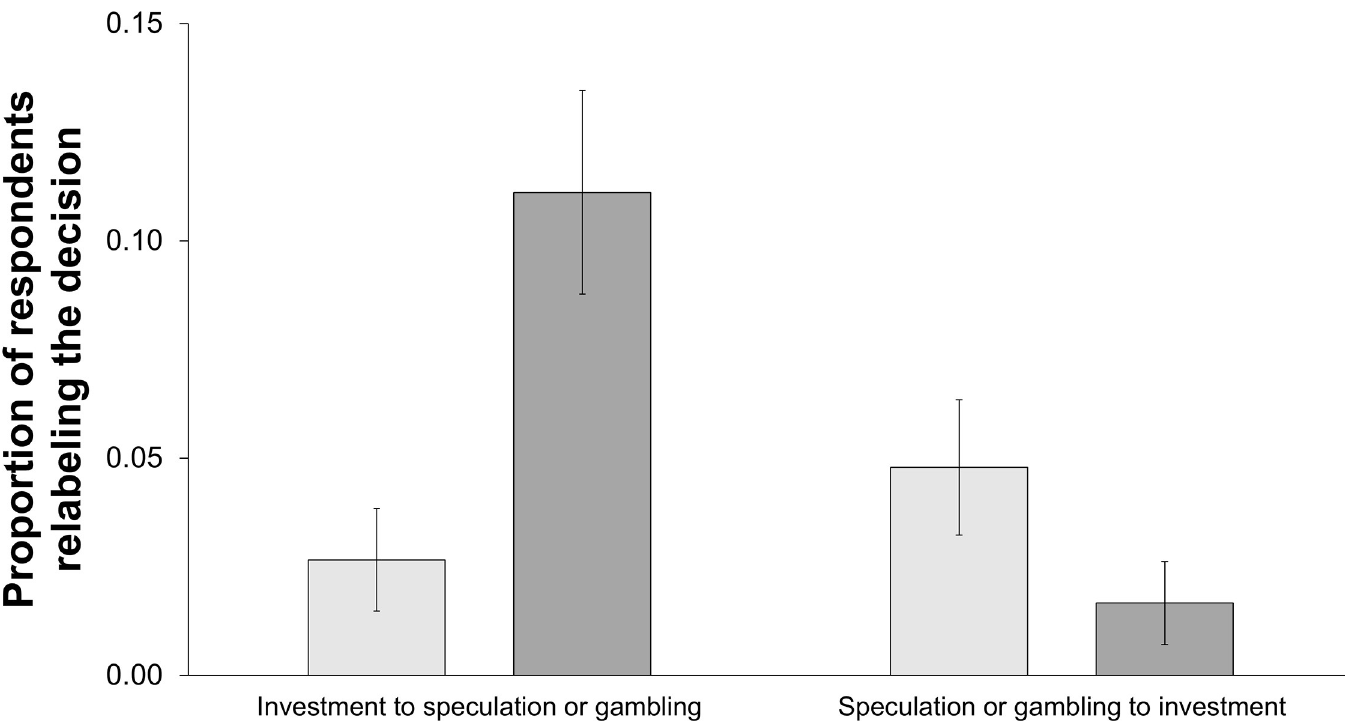
Fig 4. Proportion of respondents relabeling the decision by outcome. Note: The light-gray bar depicts the profit case and the dark-gray bar depicts the loss